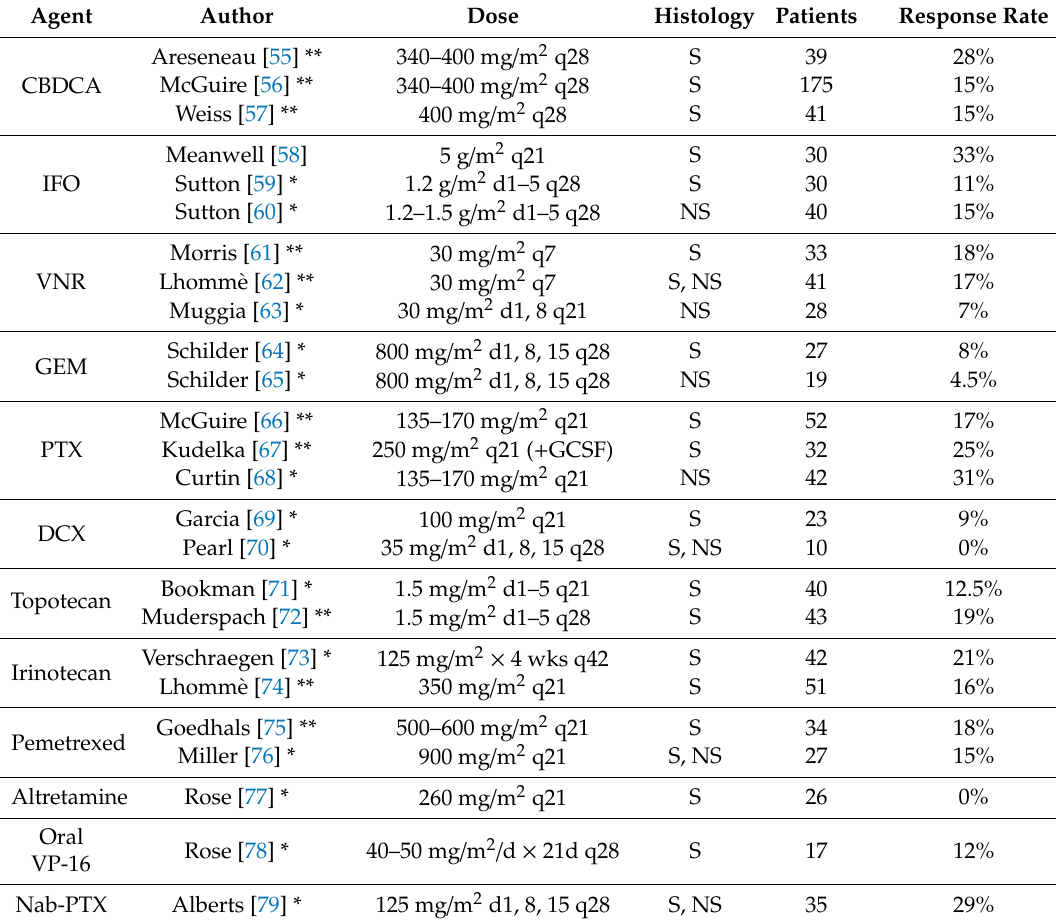
Table 1. Single agentactivity in metastatic, persistent, or recurrent carcinoma of the uterine cervix. Agent Author Dose Histology Patients Response